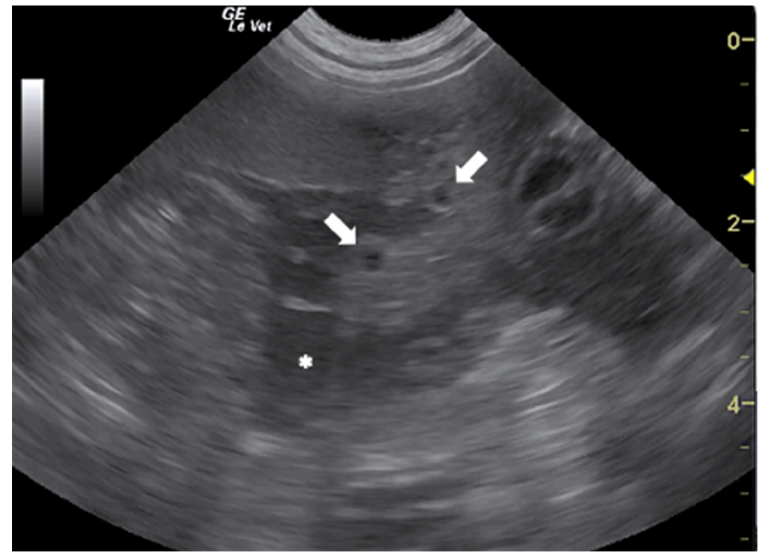
Figure 4. Ascitic effusion (*) and anechoic cystic structures in the omentum (arrows) in a dog with peritoneal mesocestodiasis. Courtesy of the Veterinary Teaching Hospital, University of Sassari